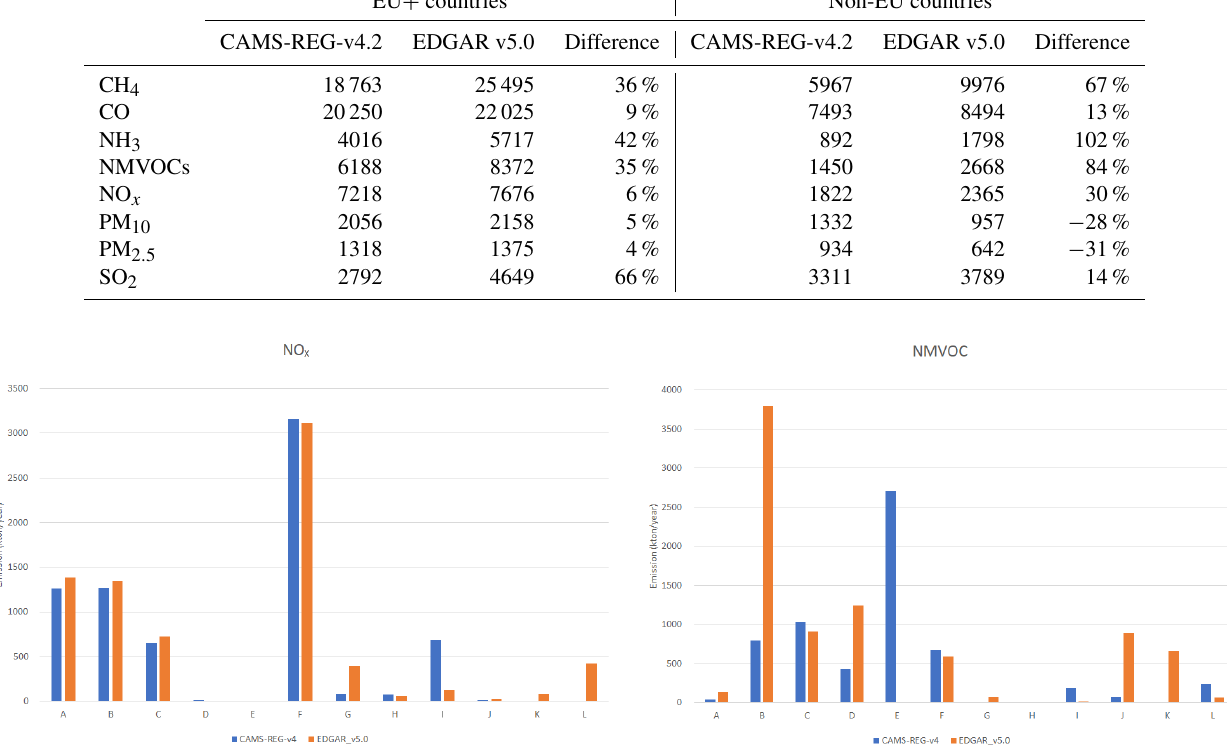
Figure 10. Comparison between CAMS-REG-v4.2 and EDGAR-v5.0 for NO x and NMVOCs for the year 2015 for EU + countries (see Table 5 for GNFR sector